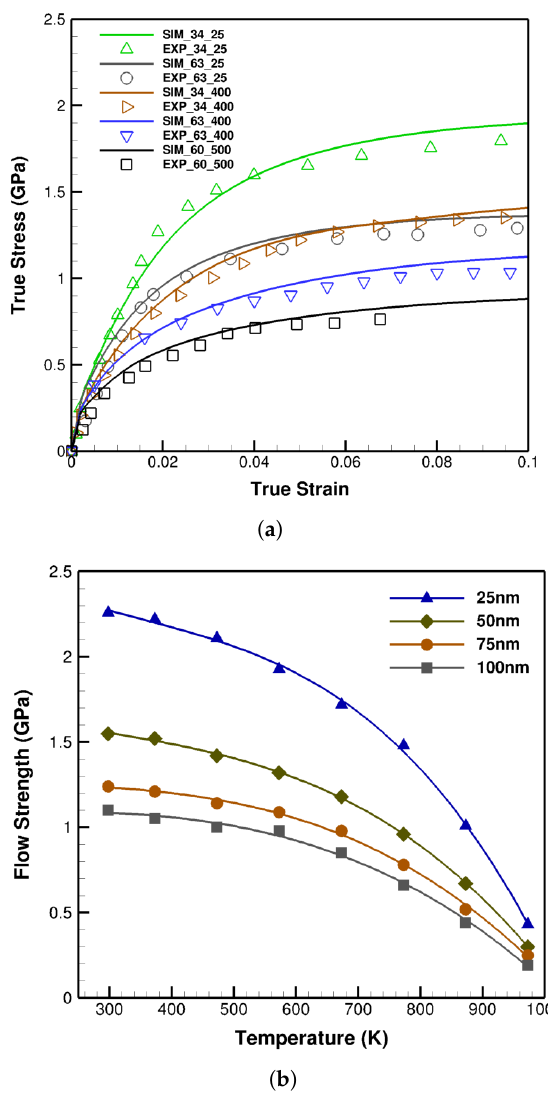
Figure 9. ( a ) The validation of the temperature-dependent constitutive model with 34 nm, 60 nm, and 63 nm Cu/Nb laminates at 25 ◦ C, 400 ◦ C, and 500 ◦ C. Symbolic points are the experimental (EXP) [49,55] and solid lines the simulation (SIM) data. ( b ) Flow strength versus temperature curves of 25 nm, 50 nm, 75 nm, and 100 nm Cu/Nb laminates at 25 ◦ C up to 700 ◦ C demonstrating the nonlinear effects of temperature growth on flow